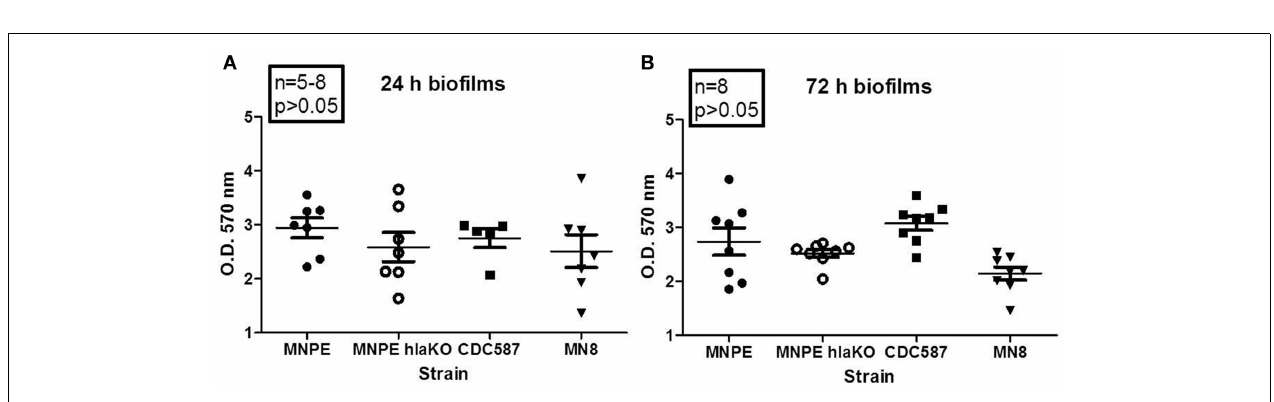
FIGURE 4 | α -Toxin promotes S. aureus biofilm formation. Explants of normal, healthy porcine vaginal mucosa were infected with ∼ 1 × 10 6 CFU of live S. aureus strain MNPE or an isogenic α -toxin deletion mutant (MNPE hla KO). FilmTracer™LIVE/DEAD stain was used to stain infected porcine vaginal mucosal epithelium explants. CLSM was used to image explants 3days post-infection. (A) Mucosa is largely viable (green staining) and intact (asymmetry). (B) Large masses of biofilm are observed on mucosa infected with wt MNPE. (C) No biofilm is observed on mucosa infected with MNPE